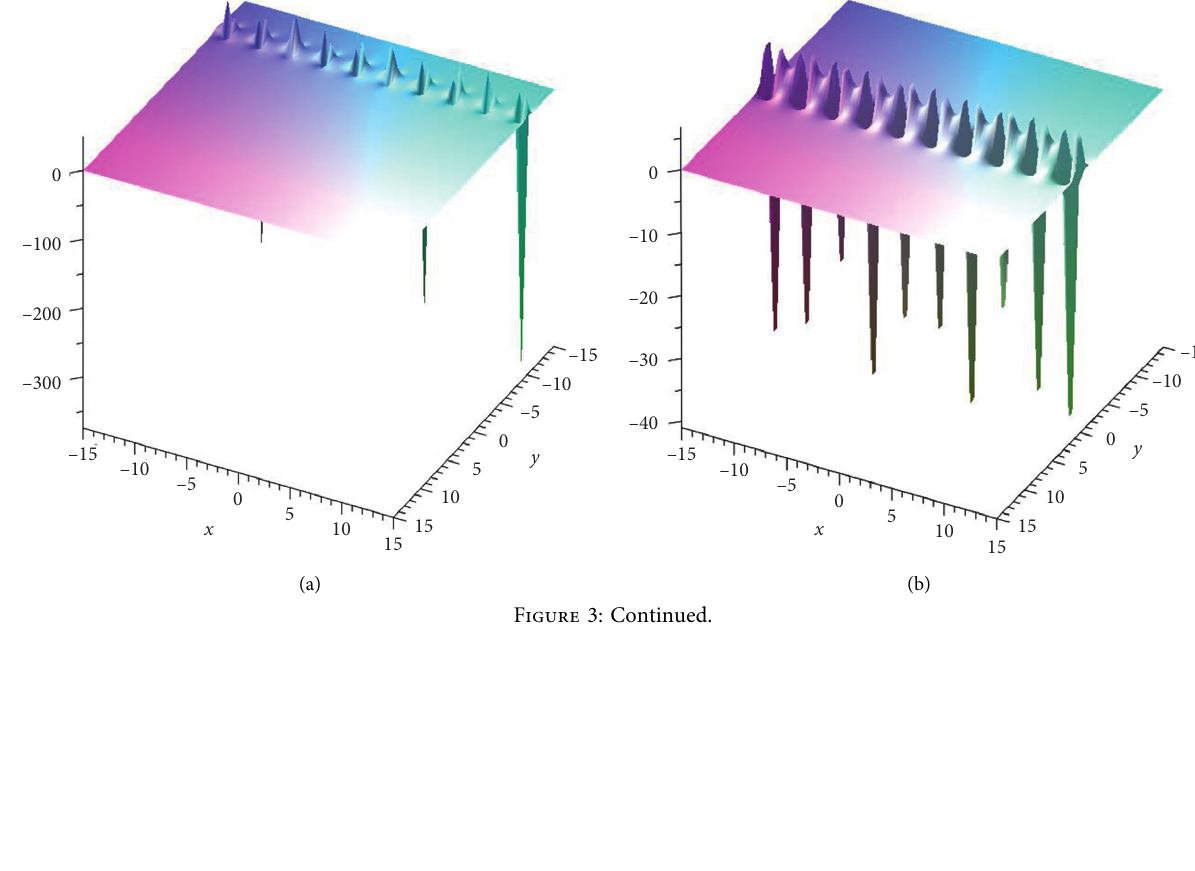
Figure 2: One soliton solution u , v of equation (1) with the parameter selections a � 0, at t � 0. (a) u . (b) v and η 02